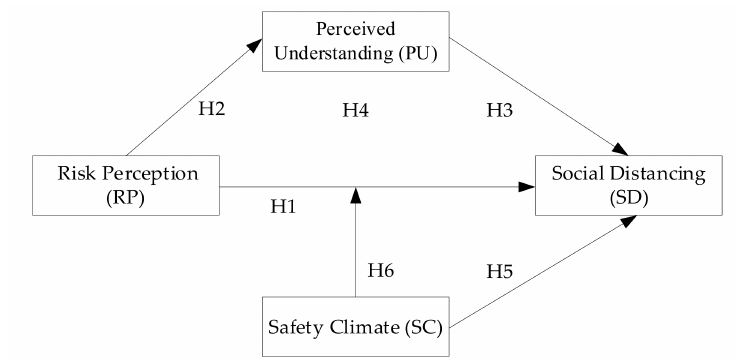
Figure 2. Conceptual